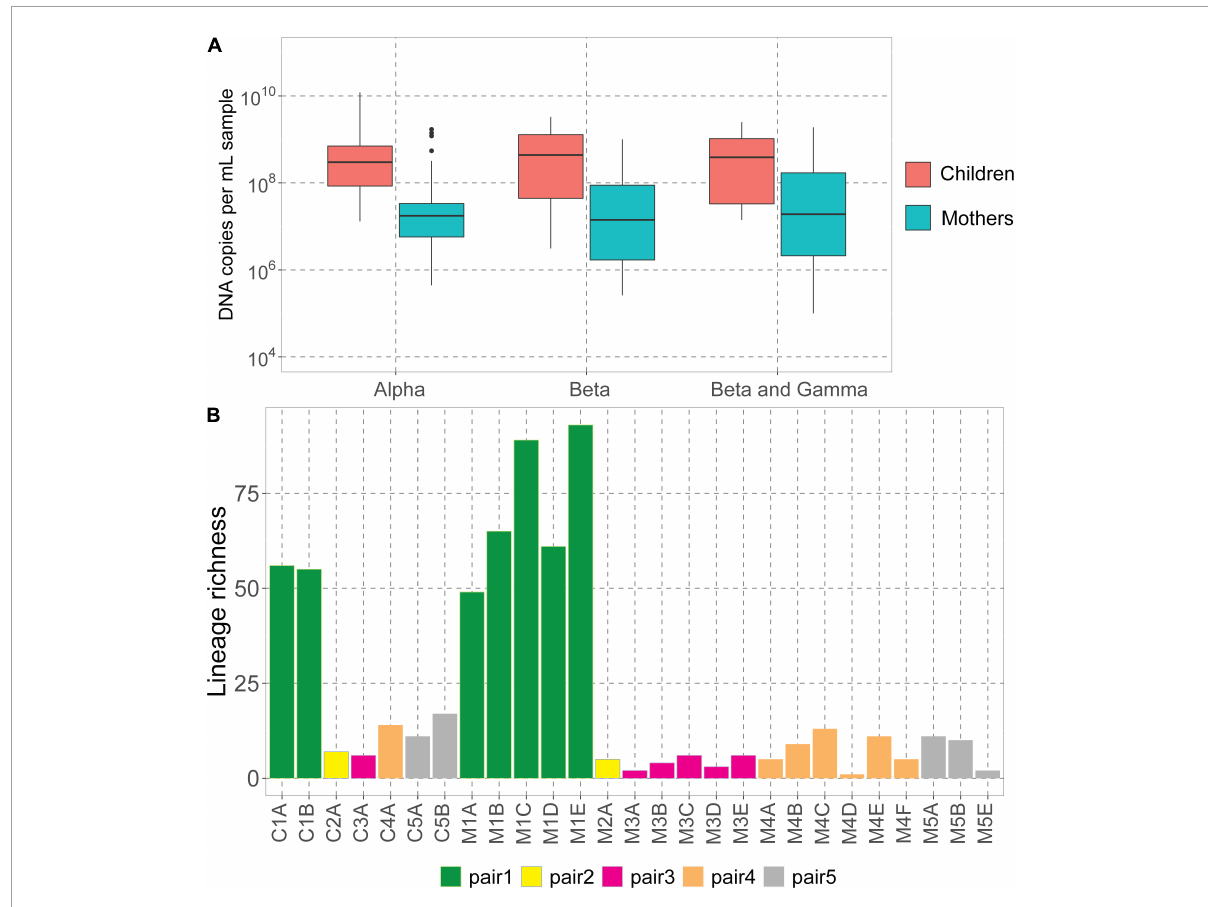
FIGURE1 Anelloviruses in mothers and their children. (A) Alpha-, beta-, and beta- and gammatorquevirus DNA copies per mL serum in mothers and children measured by genus-specific qPCR; only samples positive in the assay are included in the graph. Wilcoxon sum-rank test was used to assess the significance; all differences were insignificant ( p -value > 0.05). (B) Number of lineages (richness) in each